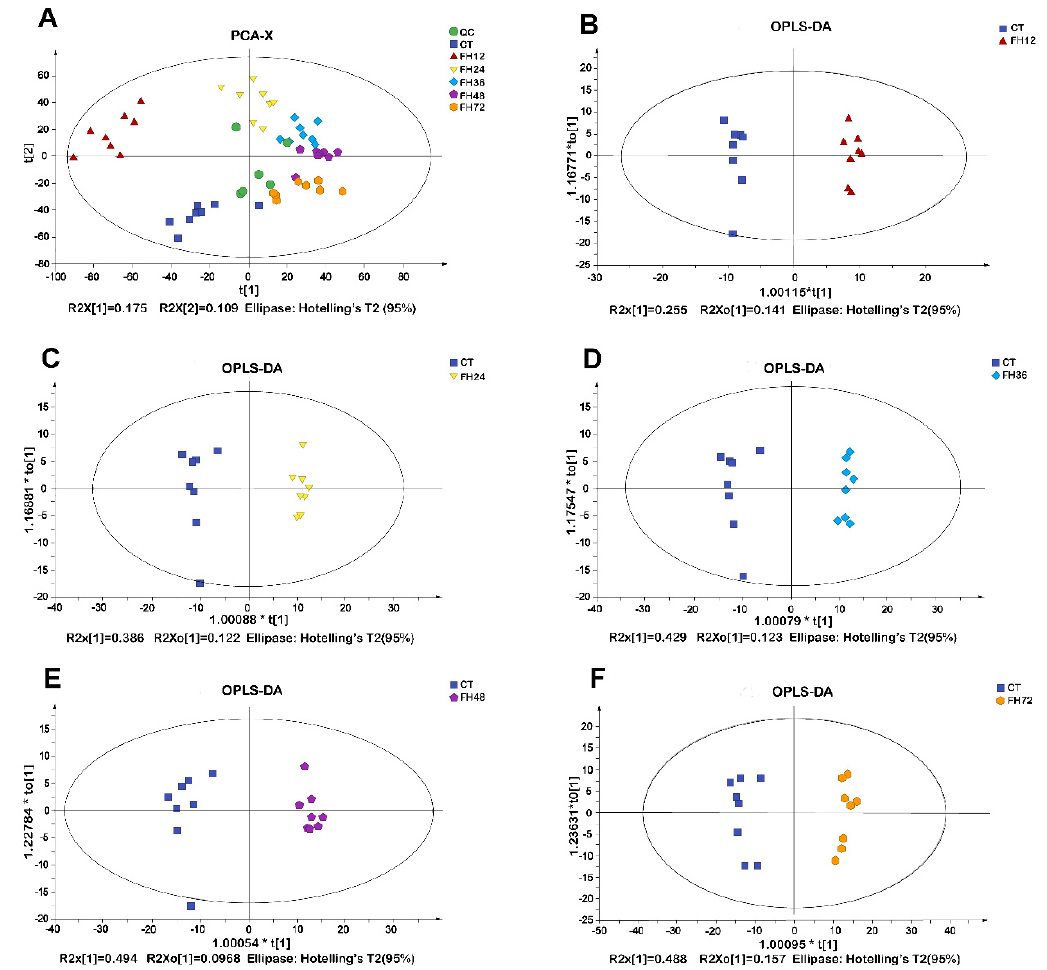
Figure 3. ( A )Principal component analysis (PCA) and ( B – F ) score plots of orthogonal partial least squares discrimination analysis (OPLS-DA) obtained from the non-fasting and fasting groups. CT—birds fed ad libitum; FH12—birds fasted for 12 h; FH24—birds fasted for 24 h; FH36—birds fasted for 36 h; FH48—birds fasted for 48 h.